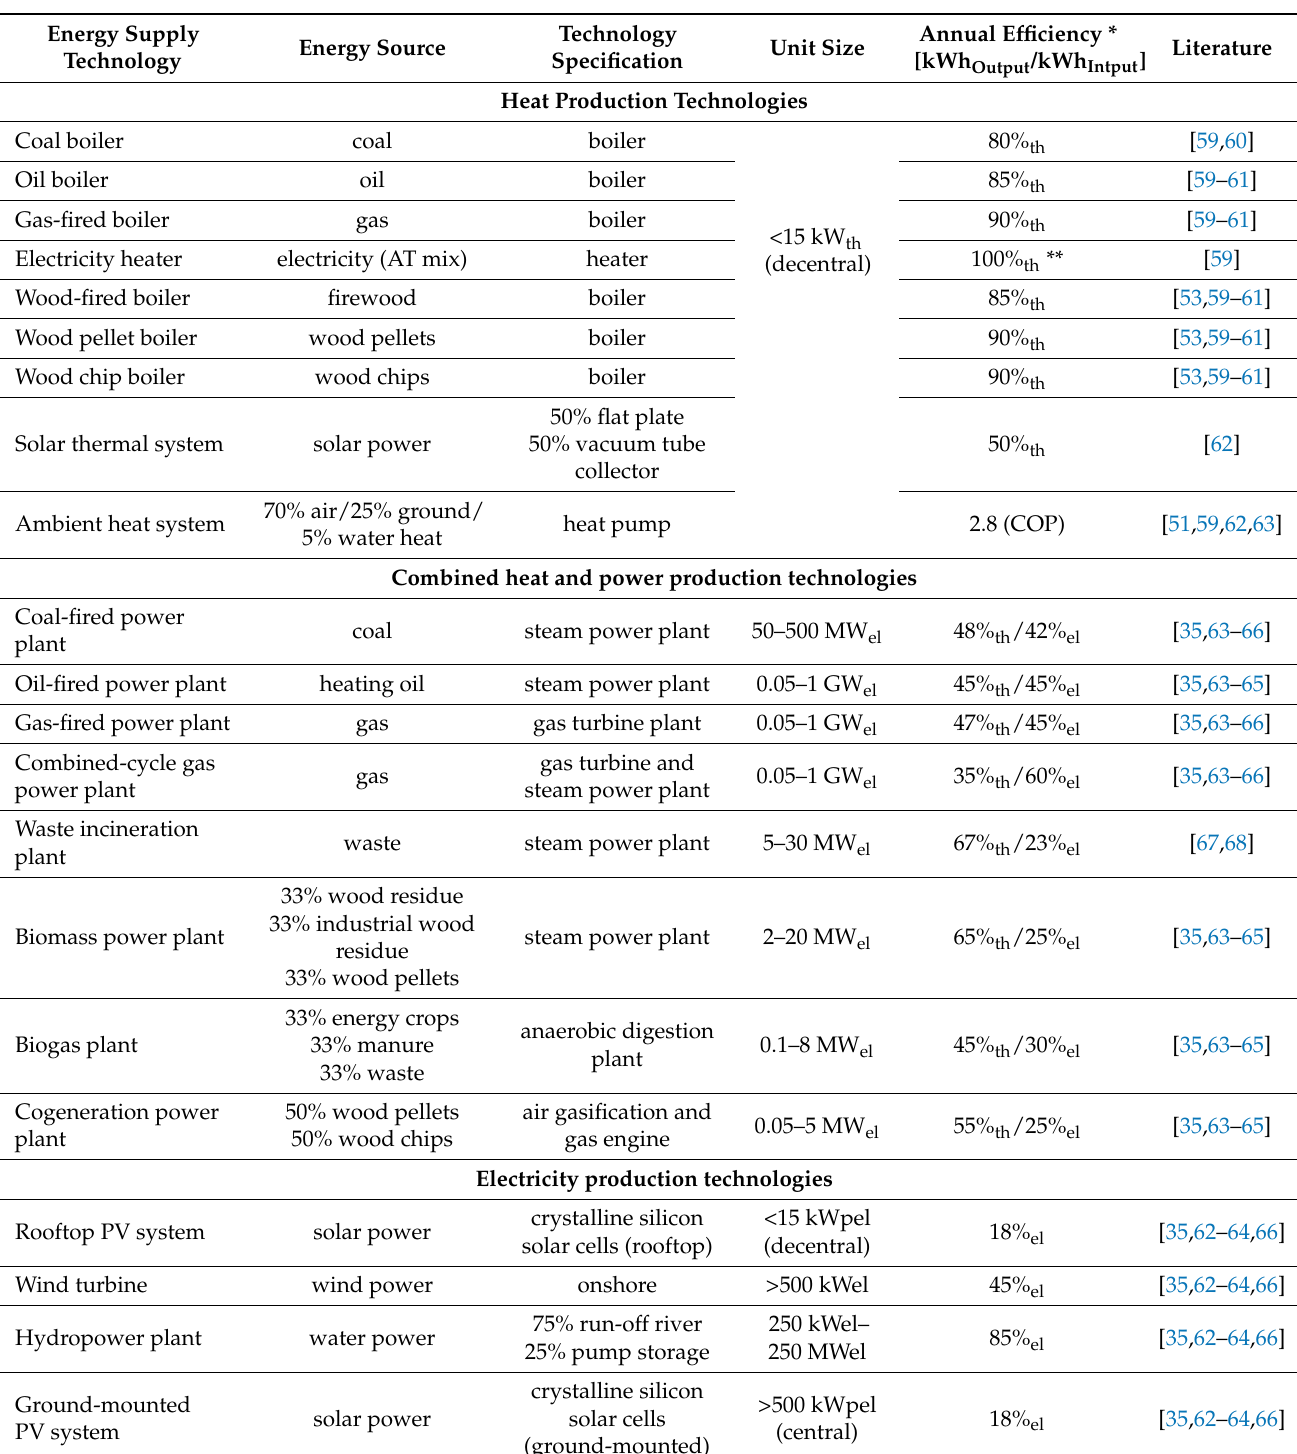
Table 1. Overview of heat and electricity supply technologies and mobility options within ENECO 2